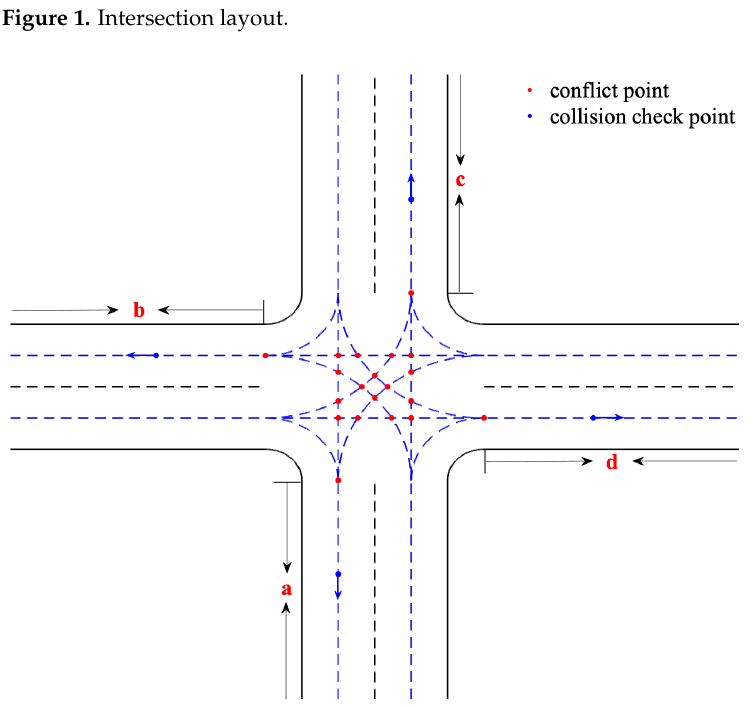
Figure 2. Conflict model at